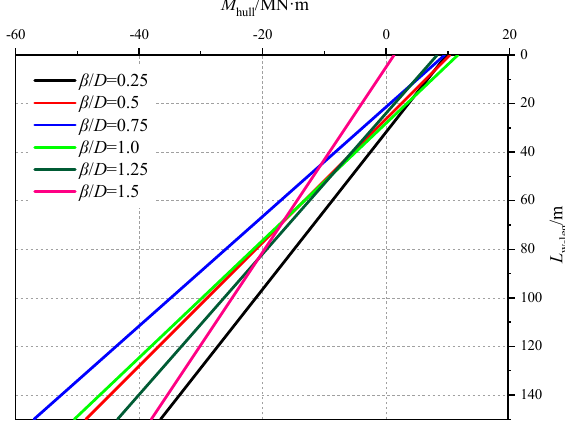
Figure 15. Maximum normalized H and M values against eccentricity ratio (flat base footing). Figure 15. Shift load reference point. Figure 15. Shift load reference point.